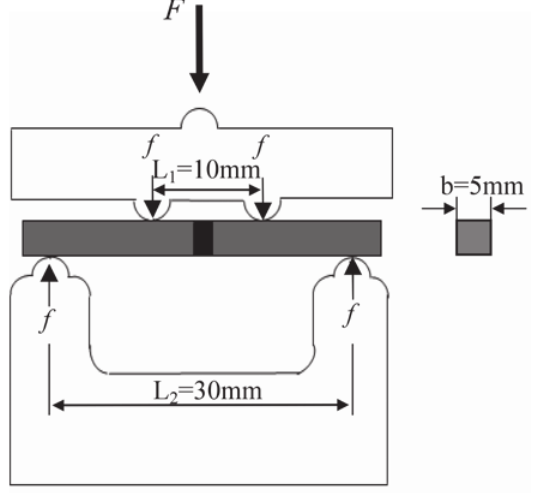
Fig. 5: Sketch of four-point bending test